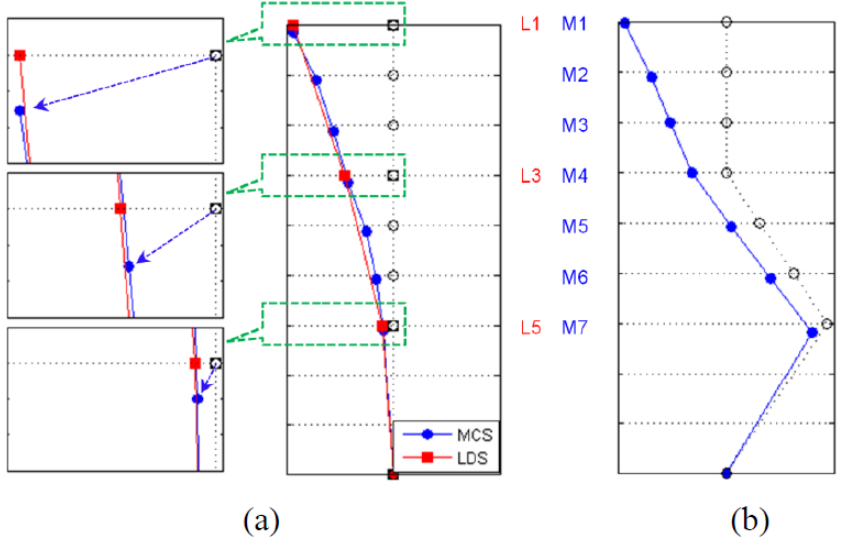
Figure 10. Mode shape. ( a ) 1st mode shape (y-axis); ( b ) 2nd mode shape